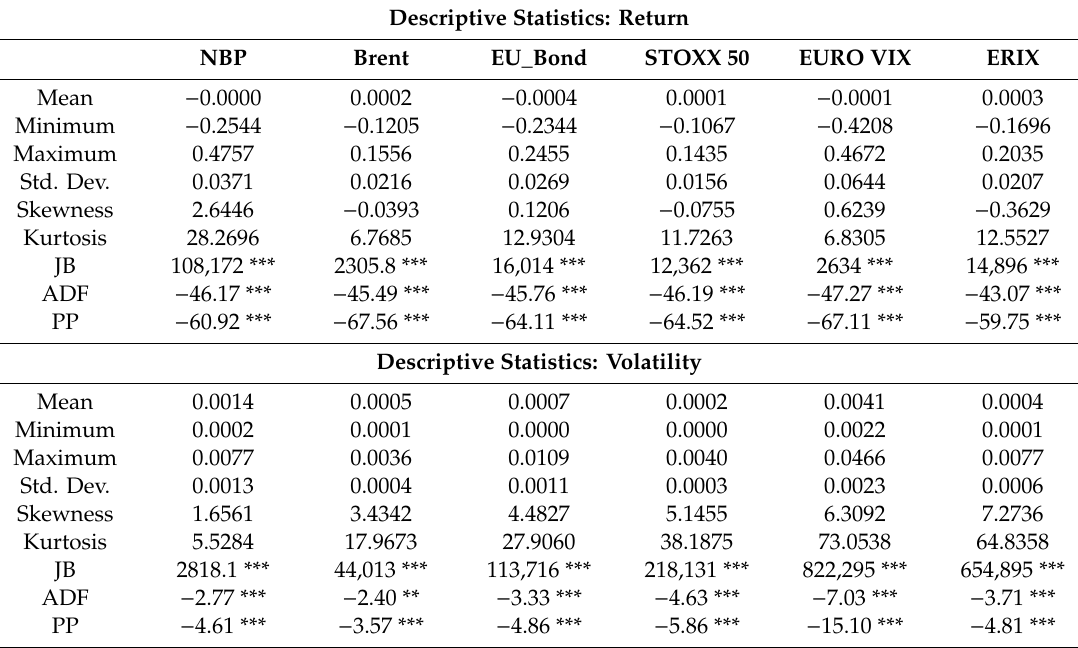
Table 3. Descriptive statistics: return and volatility series in Europe. Descriptive Statistics: